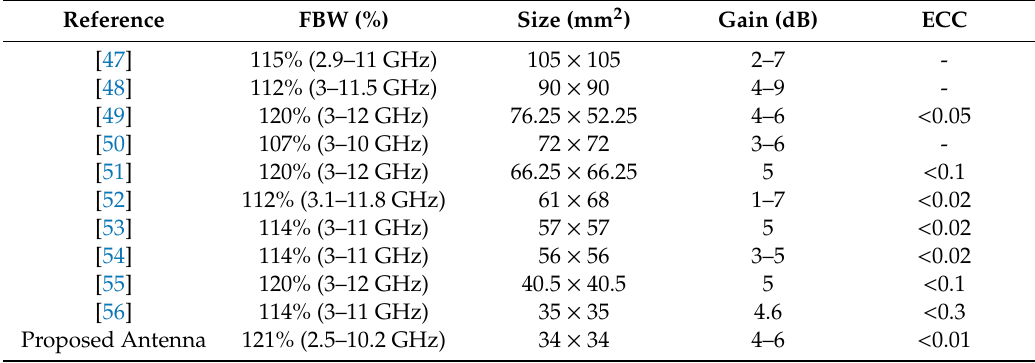
Table 2. Comparison between the Design and the Recently Reported Dual-Polarized UWB Antennas.